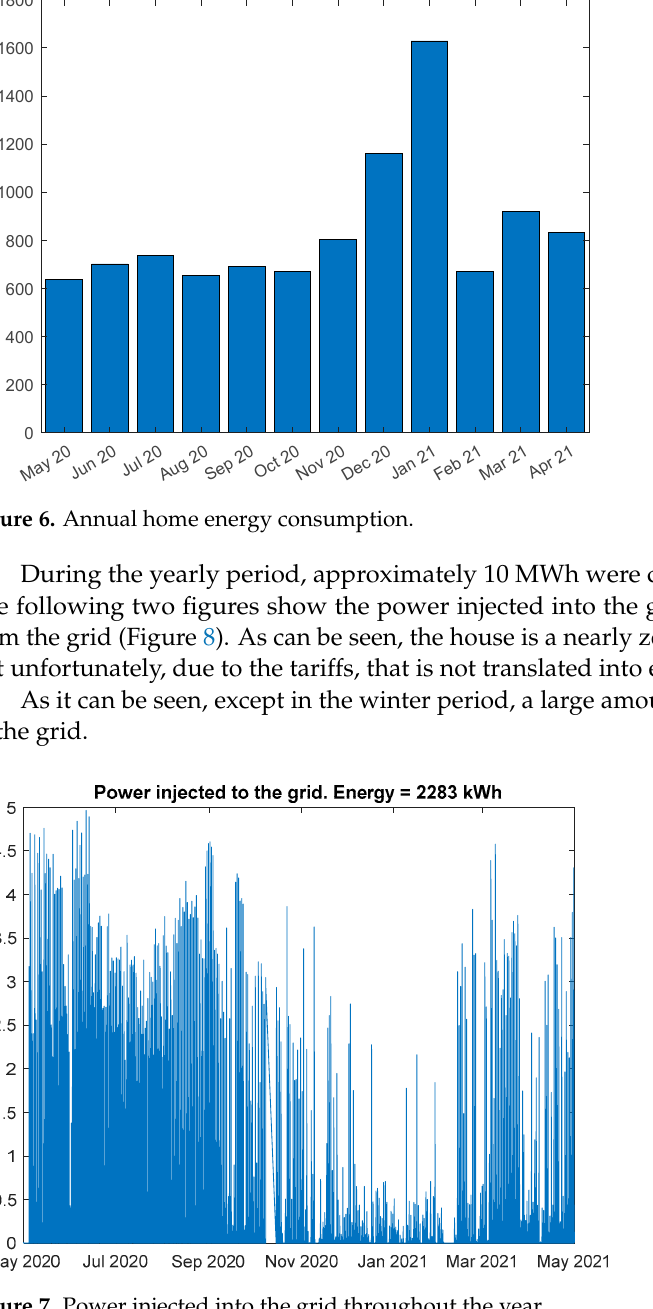
Figure 5. Maximum, mean, and minimum annual air relative humidity.